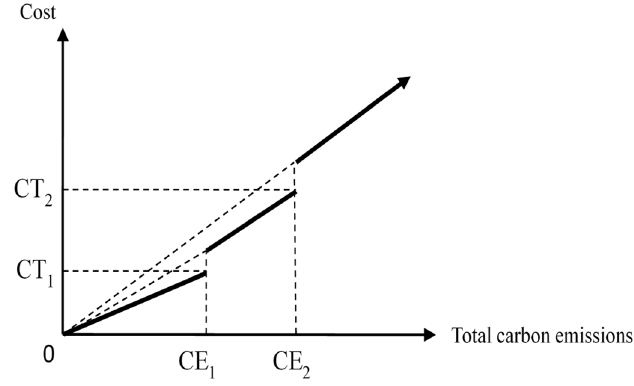
Figure 3. Carbon emission costs (taxes).